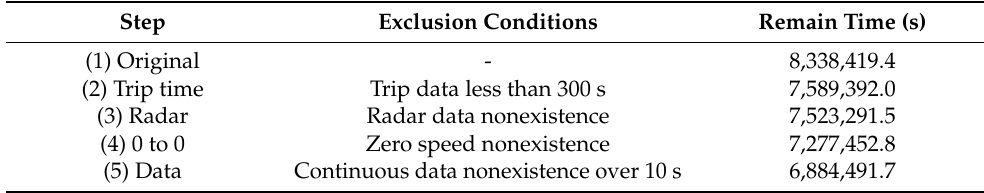
Table 2. Data classification process to ensure